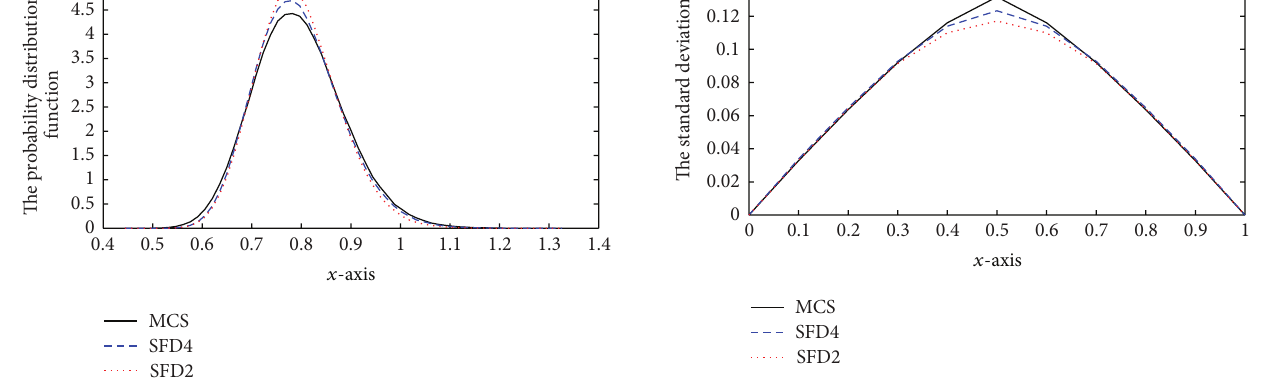
Figure 4: The SD at 𝑡 = 0.04 using SFDHC and